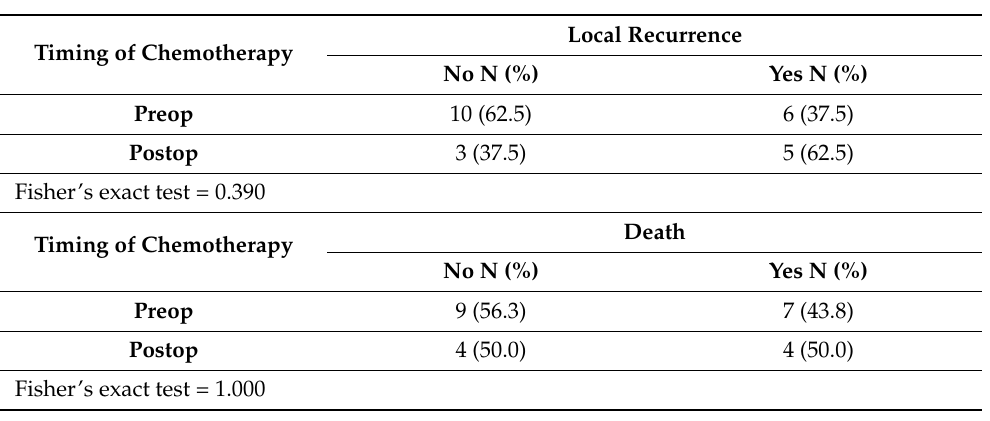
Table 4. Local recurrence and overall survival rates in relation to the timing of chemotherapy. Timing of Chemotherapy